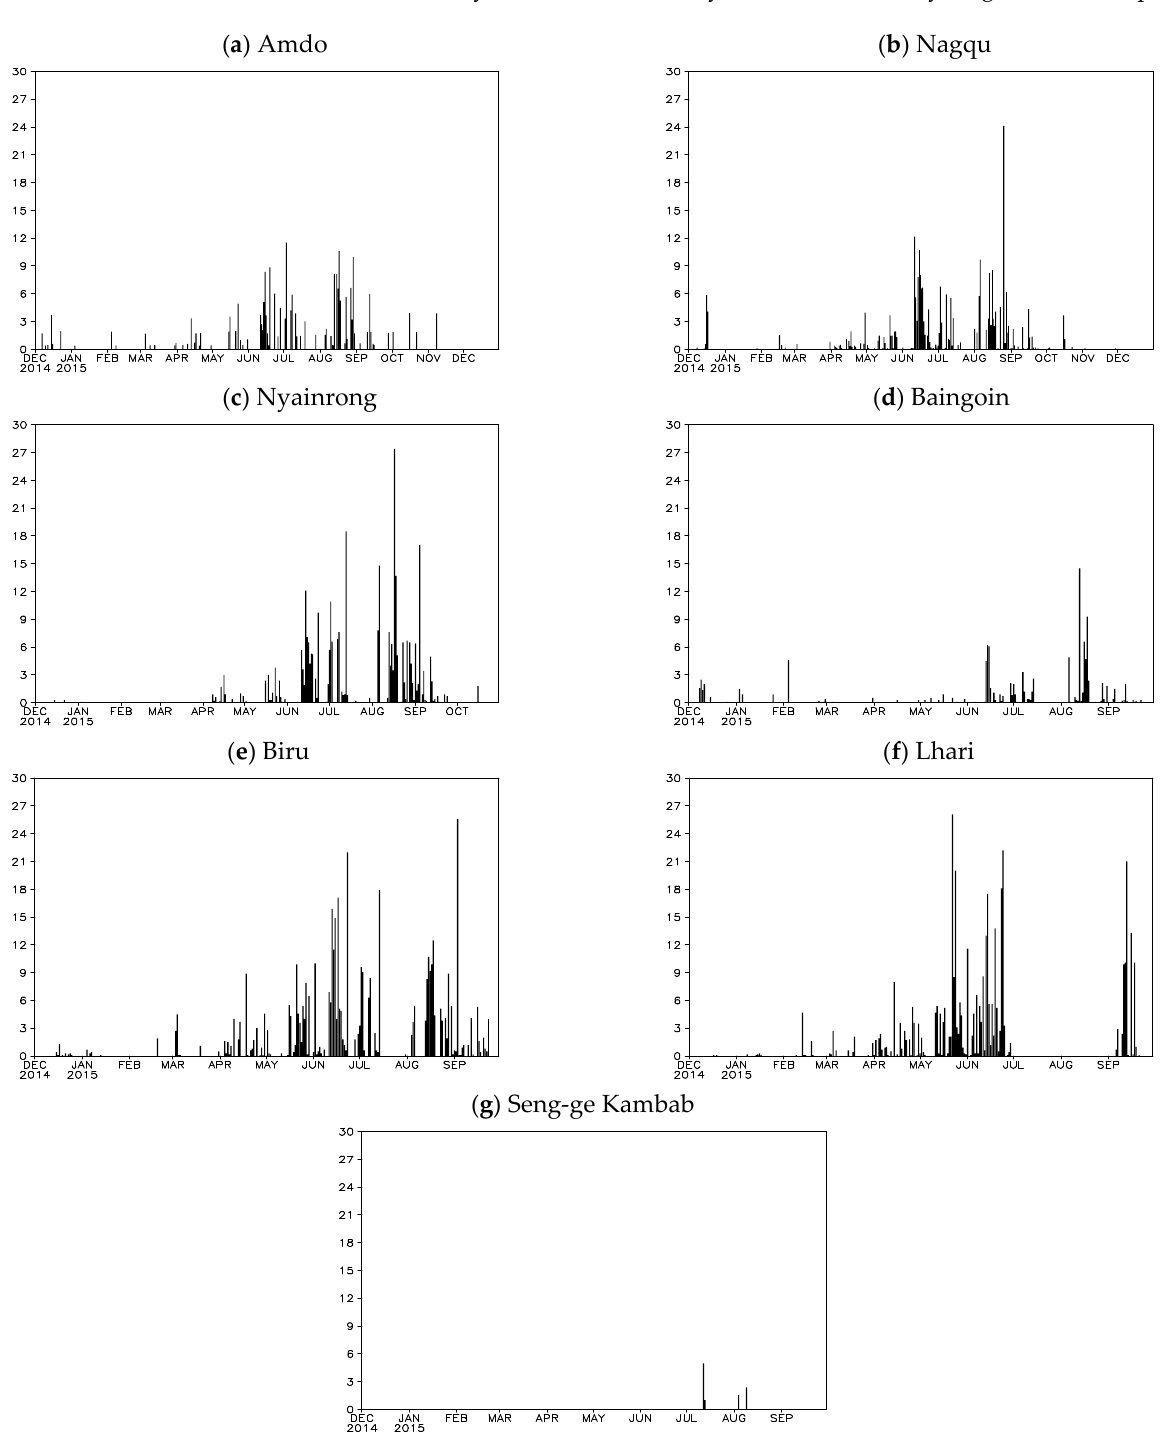
Figure 2. Daily accumulated precipitation of seven stations over Tibetan Plateau from December 2014 to December 2015 (unit: mm).